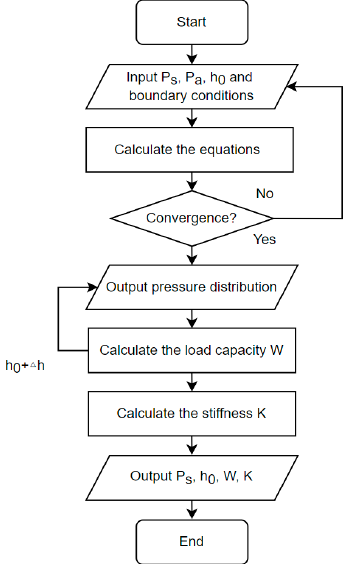
Figure 6. Calculation process of COMSOL CFD model.